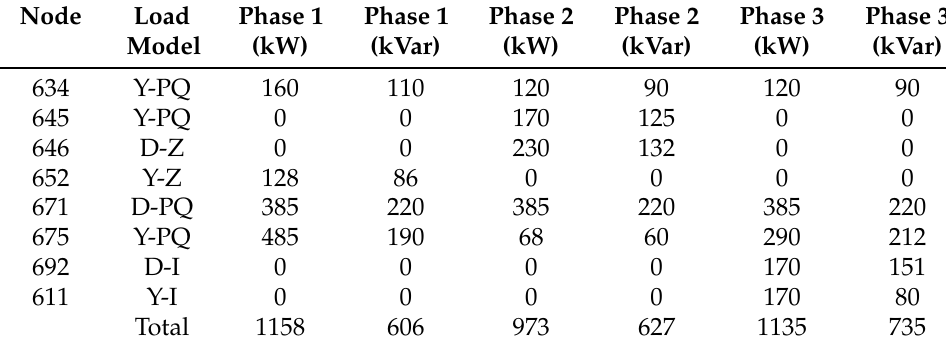
Table A1. IEEE 13 node test feeder Load